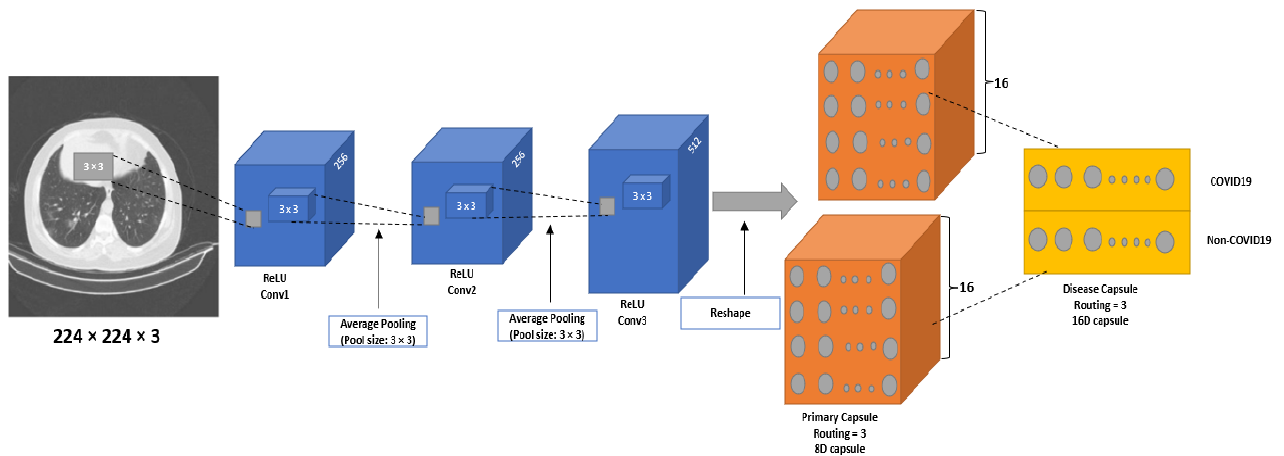
Figure 1. The proposed CapsNet architecture (CapsNetCovid). Table 2. Training Parameters for CapsNetCovid.